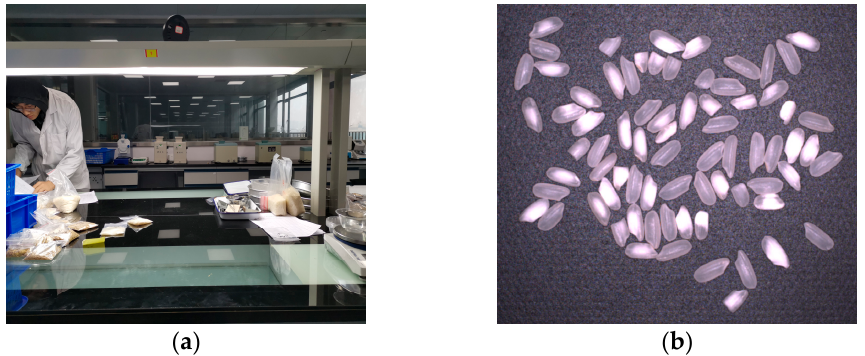
Figure 1. Traditional artificial quality detection and rice sample diagram: ( a ) from Hubei Province Cereals, Oils and Foodstuffs Quality Supervision and Inspection Center; ( b ) irregular rice mixed image.